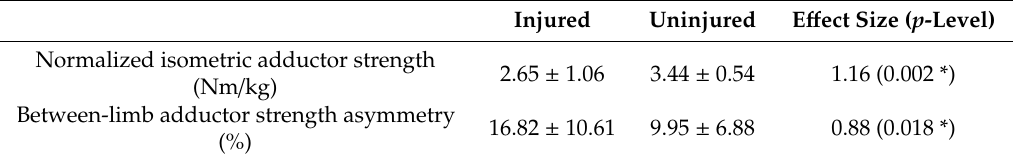
Table 1. Pre-season adductor strength performance for injured and uninjured soccer